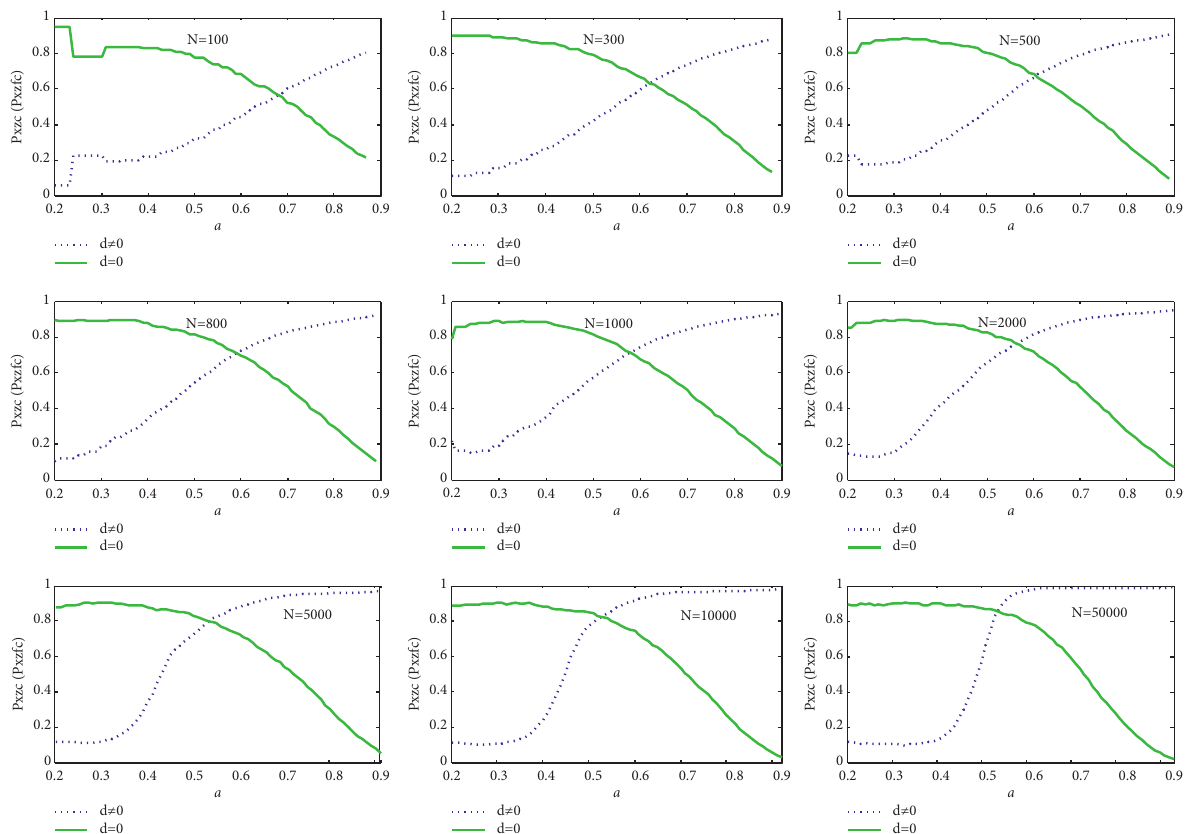
Figure 2: Judging accuracy of the existence test for long memory and no long memory.